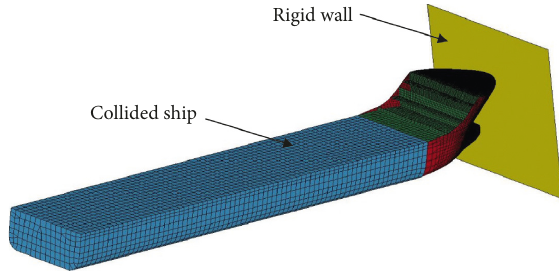
Figure 5: Vessel-rigid wall collision model. Table 1: Impact parameters and load